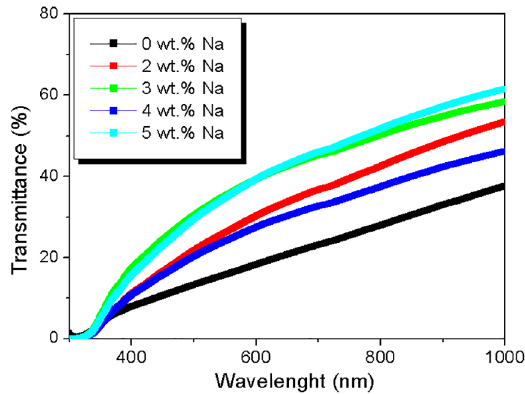
Figure 4. The transmission spectra of Na doped NiO thin films as a function of doping